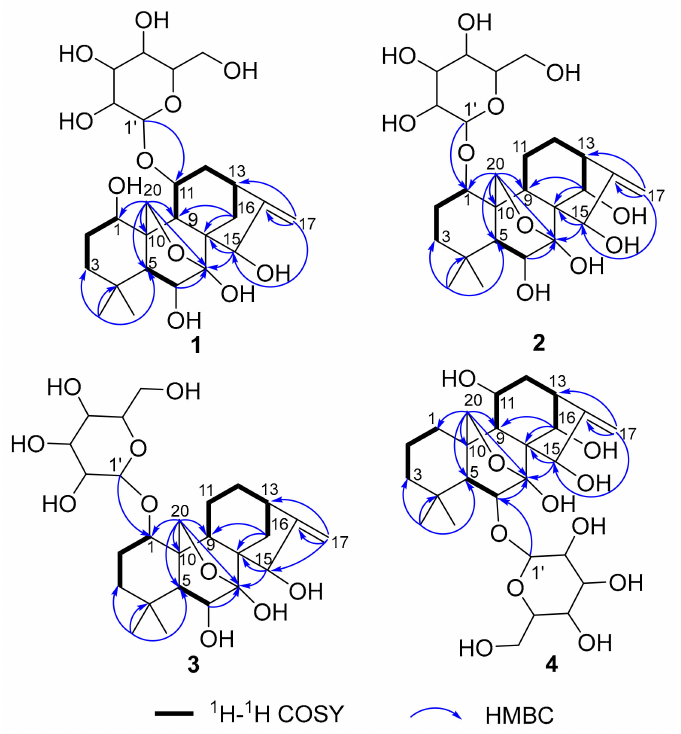
Figure 2. Key HMBC and 1 H– 1 H COSY correlations for Compounds 1 – 4